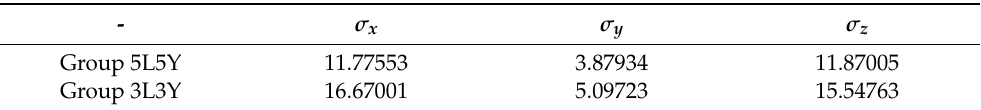
Table 6. The variance of stress generated by multilayer fullerene with different layers under the same